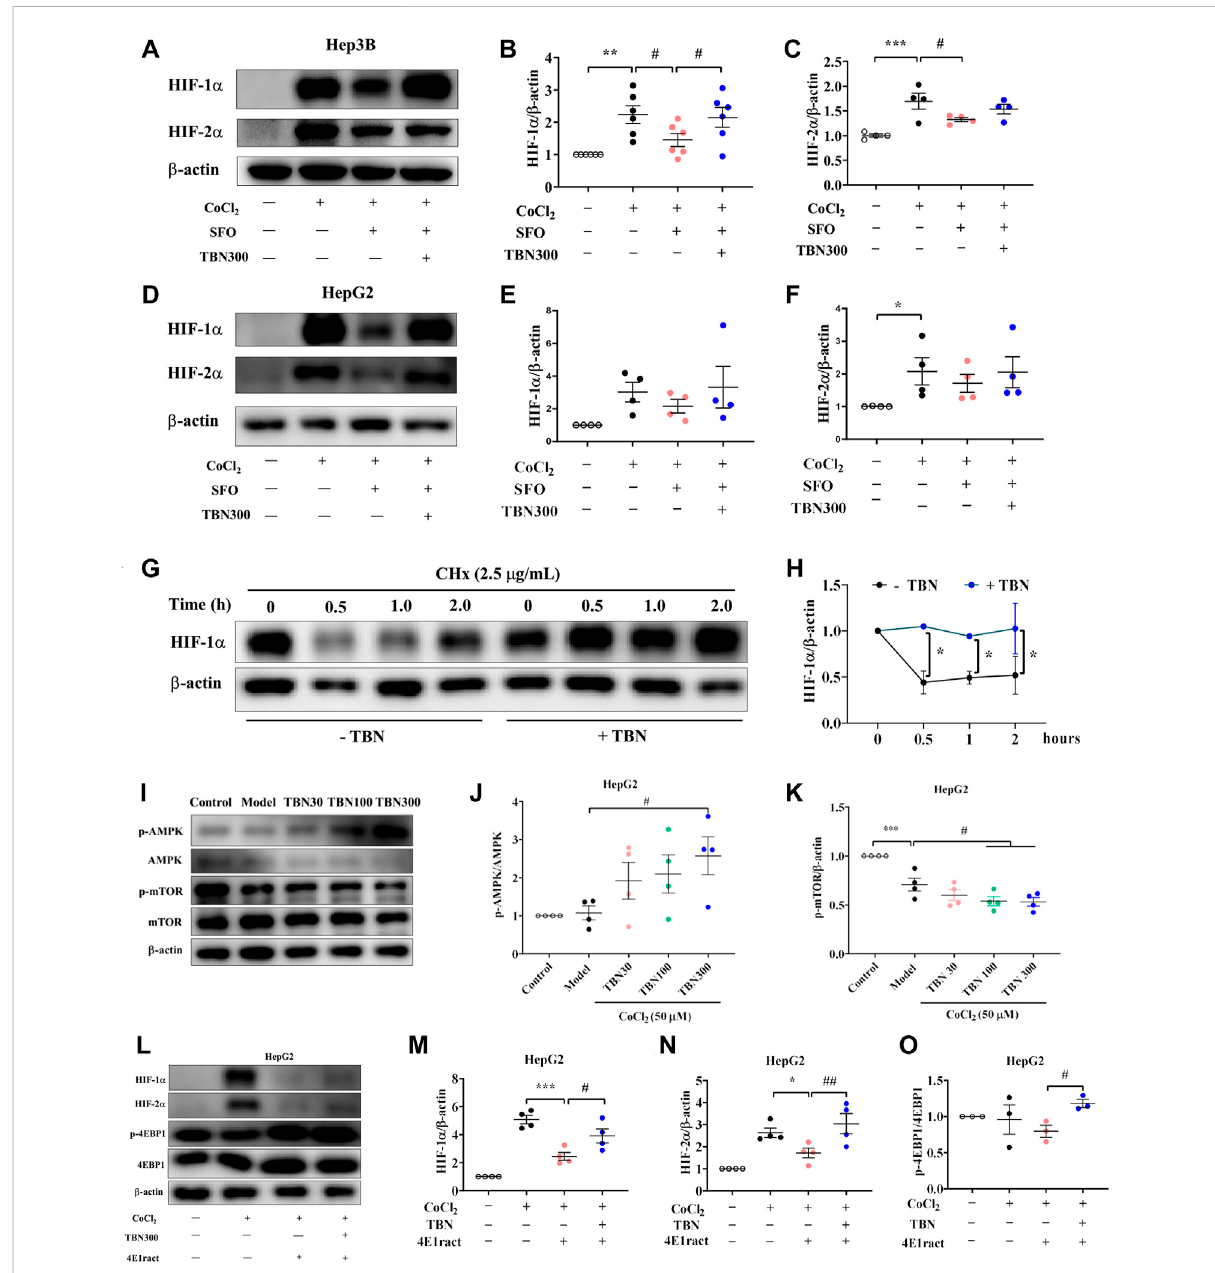
FIGURE 5 (A – F) TBN reverses the suppressive action of SFO on CoCl α and HIF-2 α protein expression in Hep3B and HepG2 cells. 2 -induced increments of HIF-1 (G,H) TBNeffectsonHIF-1 α andHIF-2 α proteinlevelsinHep3Bcellsbywesternblotanalysis. (I – K) EffectsofTBNonexpressionofAMPK/mTORinCoCl 2 - induced HepG2 cells. (L – O) HIF-1 α , HIF-2 α and p-4EBP1 expression with or without 4E1rcat in HepG2 cells. [ n = 3 – 6 for each group in Figure (A – O) ]. * p < 0.05; ** p < 0.01; *** p < 0.001vs.Control; # p < 0.05vs.CoCl 2 -inducedModel,CoCl 2 -SFO-inducedgroup. * p < 0.05; *** p < 0.001;vs.4E1rcat-induced group; # p < 0.05; ## p < 0.01 vs. TBN group. SFO: saccharate ferric oxide; CoCl 2 : cobalt chloride; HIF: hypoxia-inducible